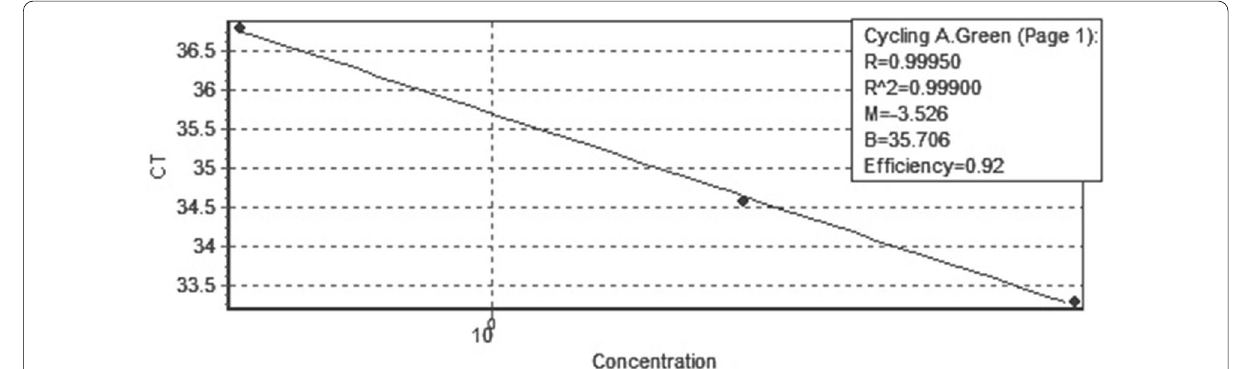
Fig. 5 Standard curve generated from Fluka CRM dilutions (0.5, 2, 5) using Taq Man Probe